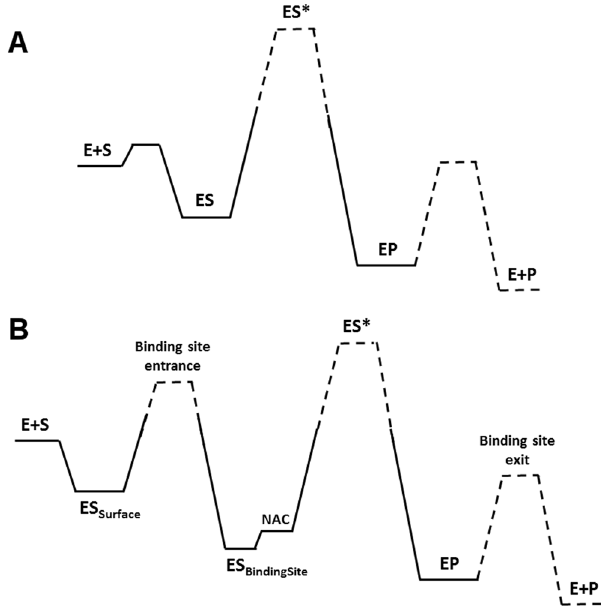
Figure 7. Schematic representation of the free energy profiles. The Michaelis-Menten model ( A ) and the proposed catalytic cycle of CA. ( B ) The states are represented as E + S for the free substrate, ES for the bound substrate state and ES * for the transition state of the chemical reaction. The cycle continue with the product bound to the enzyme (EP) and the free product after leaving the binding pocket (E + P). In CA, the bound state on the surface and within the binding pocket are distinct (ES Surface and ES BindingPocket ). Within the binding pocket, two sub-sites indicate the unproductive and the productive (NAC) binding